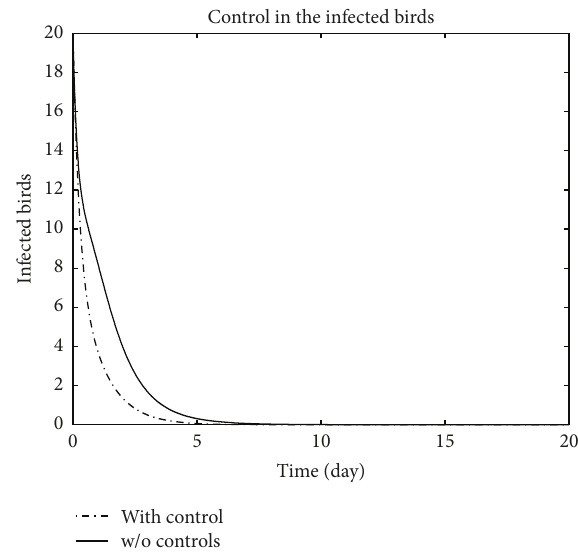
Figure 6: The plot represents the population of susceptible birds with and without control.